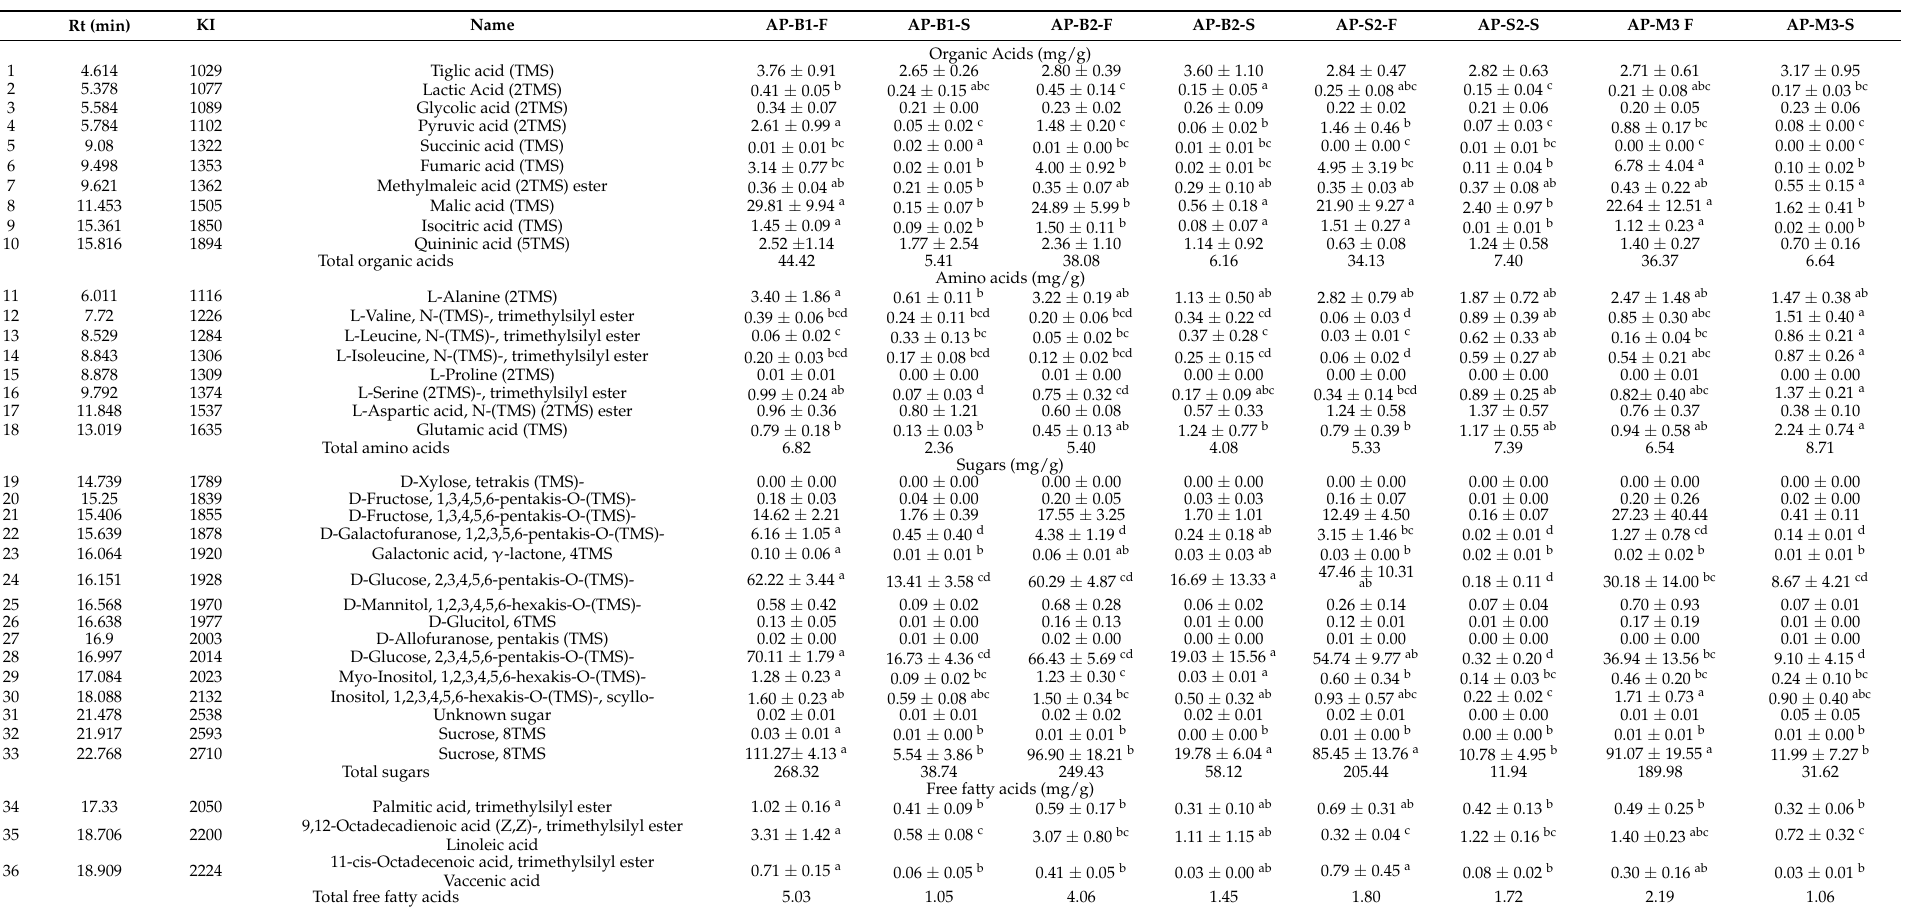
Table 2. Silylated metabolites expressed in mg/g in apricot fruits and seed kernels analyzed via GC–MS, n = 3. For codes, refer to Table 1. a–d Different letters in